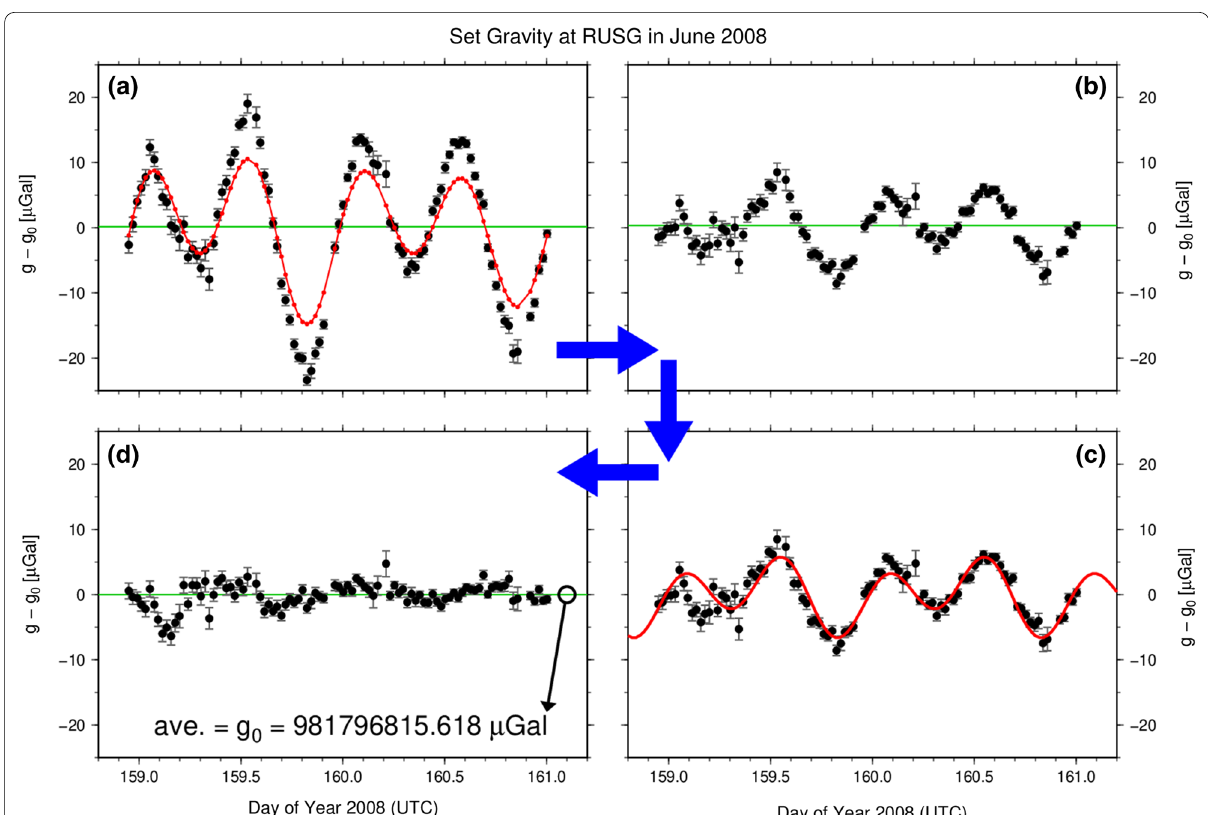
Fig. 2 Correction of the ocean tide loading effect from the AG data was collected at RUSG in 2008. a The set gravity data before the ocean loading effect was corrected (black circles) and the gravity change due to the ocean loading effect expected by Inazu et al. (2009) (red line). b The set gravity data after the ocean loading effect was corrected using the Inazu model (black circles). c The set gravity data after the ocean loading effect was corrected using the Inazu model (black circles) and the diurnal/semidiurnal regression curve for the gravity data (red line). d The set gravity data after the ocean loading effect was corrected using both the Inazu model and the diurnal/semidiurnal regression (black circles). In all the panels, the gray bars and green lines indicate the standard error and weighted average values of the set gravity data, respectively, and the vertical axis refers to the average value in panel d , which is defined by g